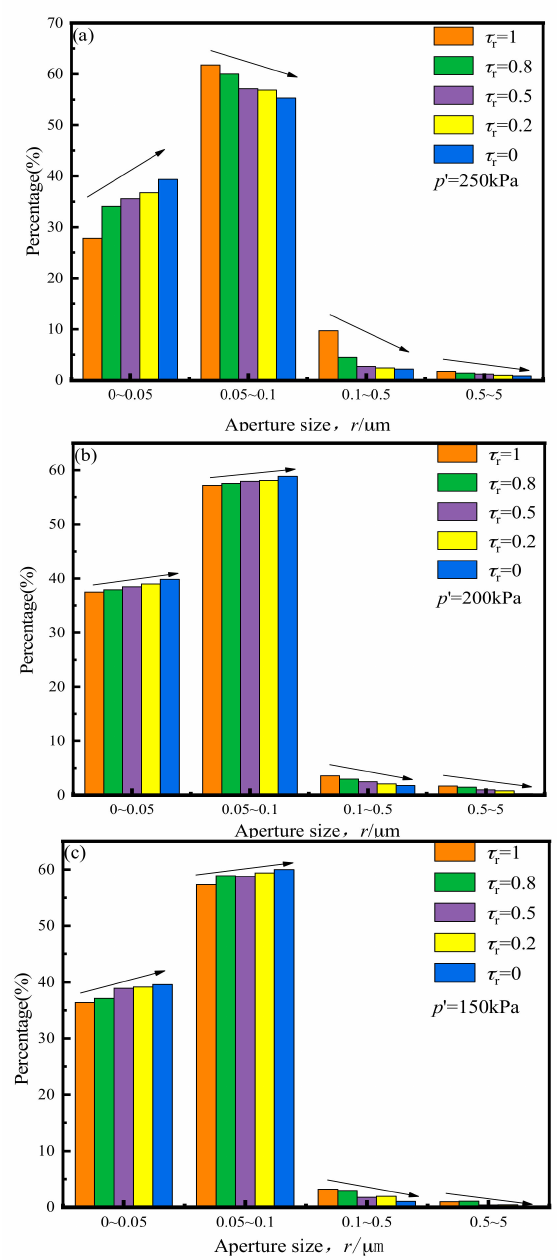
Figure 16. Pore size distribution under the influence of τ r : ( a ) p (cid:48) = 250; ( b ) p (cid:48) = 200; ( c ) p (cid:48) = 150. As τ r decreases, the pore distribution in the soft clay samples under various p (cid:48) values show a significant decrease in the number of large pores and an increase in that of small pores. Taking p (cid:48) values of 250 and 150 kPa as examples, when p (cid:48) is 250 kPa, the τ r reduces, and the proportion of pores with a diameter of r < 0.05 µ m increases significantly, the percentage of pores of other sizes decreases as τ r decreases. When p (cid:48) is 150 kPa, as τ r decreases, the number of pores with diameters between 0.05 and 0.1 µ m no longer increases significantly. At that point, larger pores (r > 0.5 µ m) are transformed into pores with diameters in the range of from 0.05 to 0.1 µ m. Once τ r = 0, the pores with diameters between 0.5 and 5 µ m have essentially disappeared. This is because a large proportion of large pores became filled with broken and slipping soil particles and converted into smaller diameter